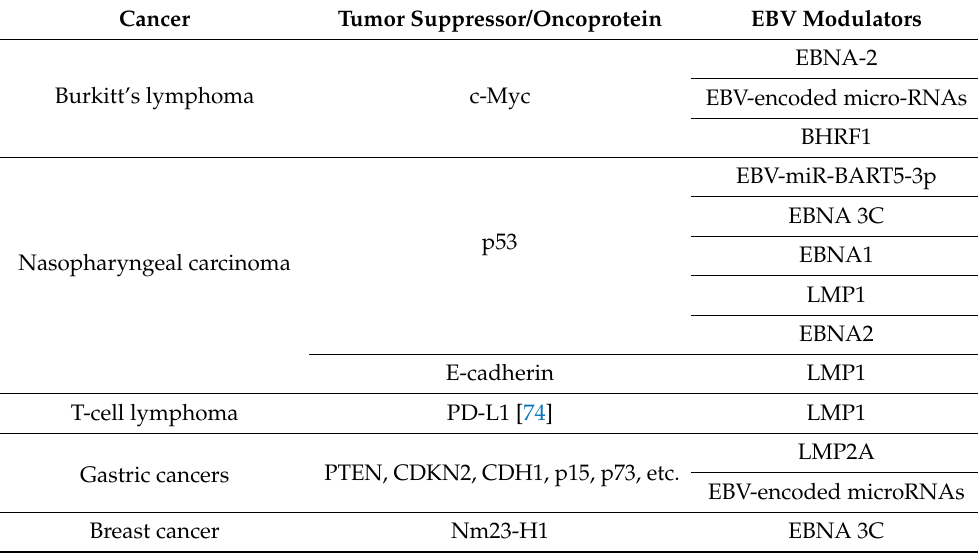
Table 1. Tumor suppressor/oncoprotein and EBV modulators in various cancers. Cancer Tumor